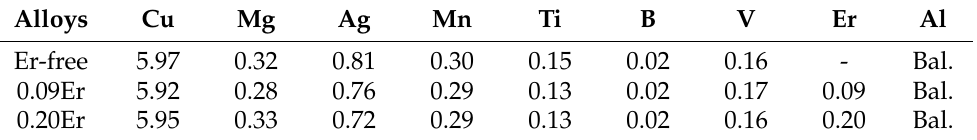
Table 1. Chemical composition of the studied Al-Cu-Mg-Ag-(Er) alloys (wt %).